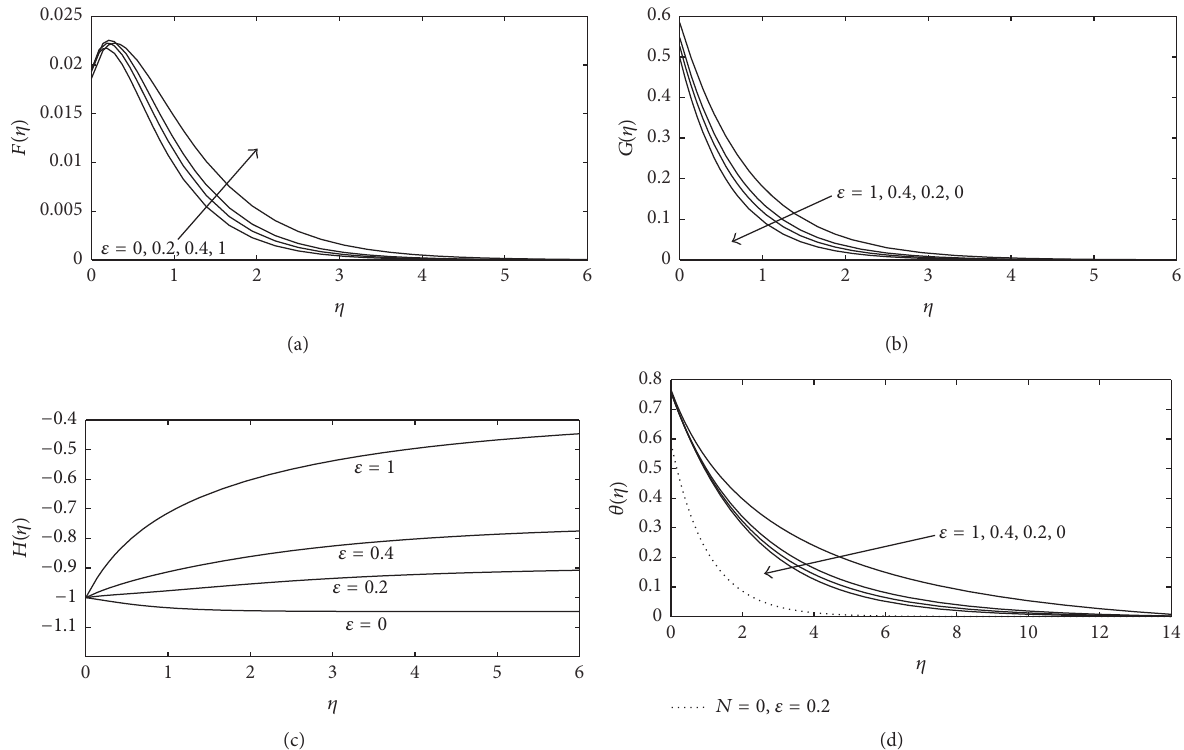
Figure 8: Effect of variation in the relative temperature difference parameter on the (a) radial, (b) tangential, (c) axial, and (d) temperature velocity profiles when 𝐾 = 1 , 𝑊 𝑠 = −1 , Kn = 0.05, Re = 100, 𝑁 = 1 , and Pr = 1.